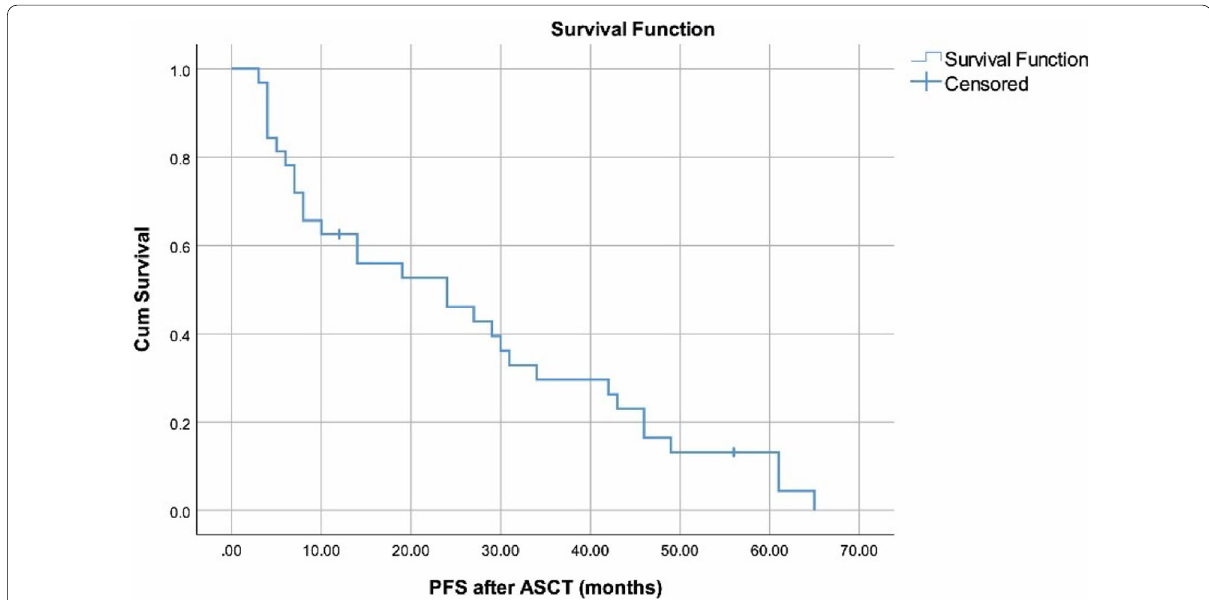
Fig. 6 Progression-free survival after autologous stem cell transplantation